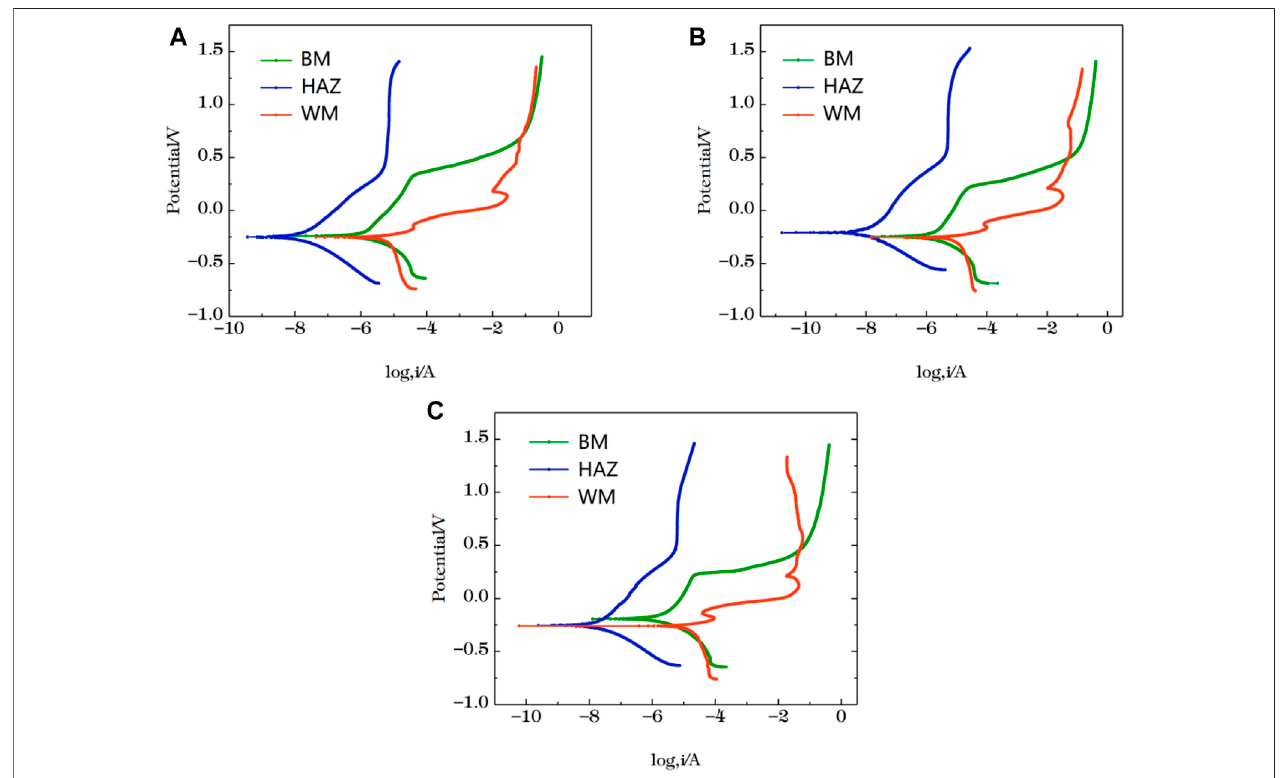
FIGURE 11 | Polarization curves of the three zones after immersion in arti fi cial seawater for 12 h (A) 25 ° C (B) 35 ° C (C) 45 ° C.